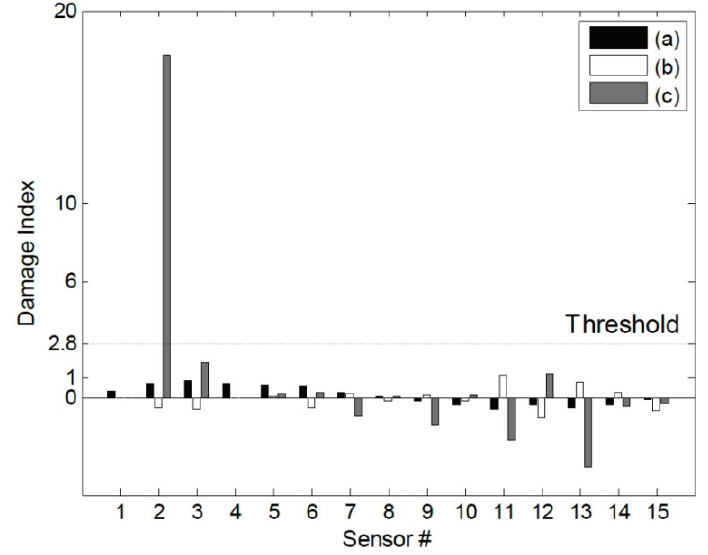
Figure 13. Estimations of the damage location for DC1 using the three different methods: ( a ) the ULS method, ( b ) the ULS curvature method, and ( c ) the NULS curvature